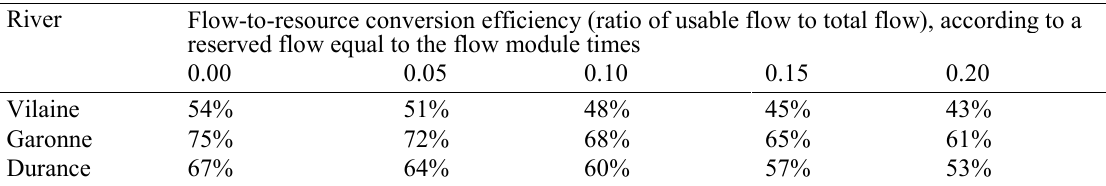
Table 3 Flow-to-resource conversion efficiency simulated for the three French rivers under different hypotheses of in-stream reserved flow. Other hypotheses: no reservoir storage, constant (urban) demand equal to the flow module year